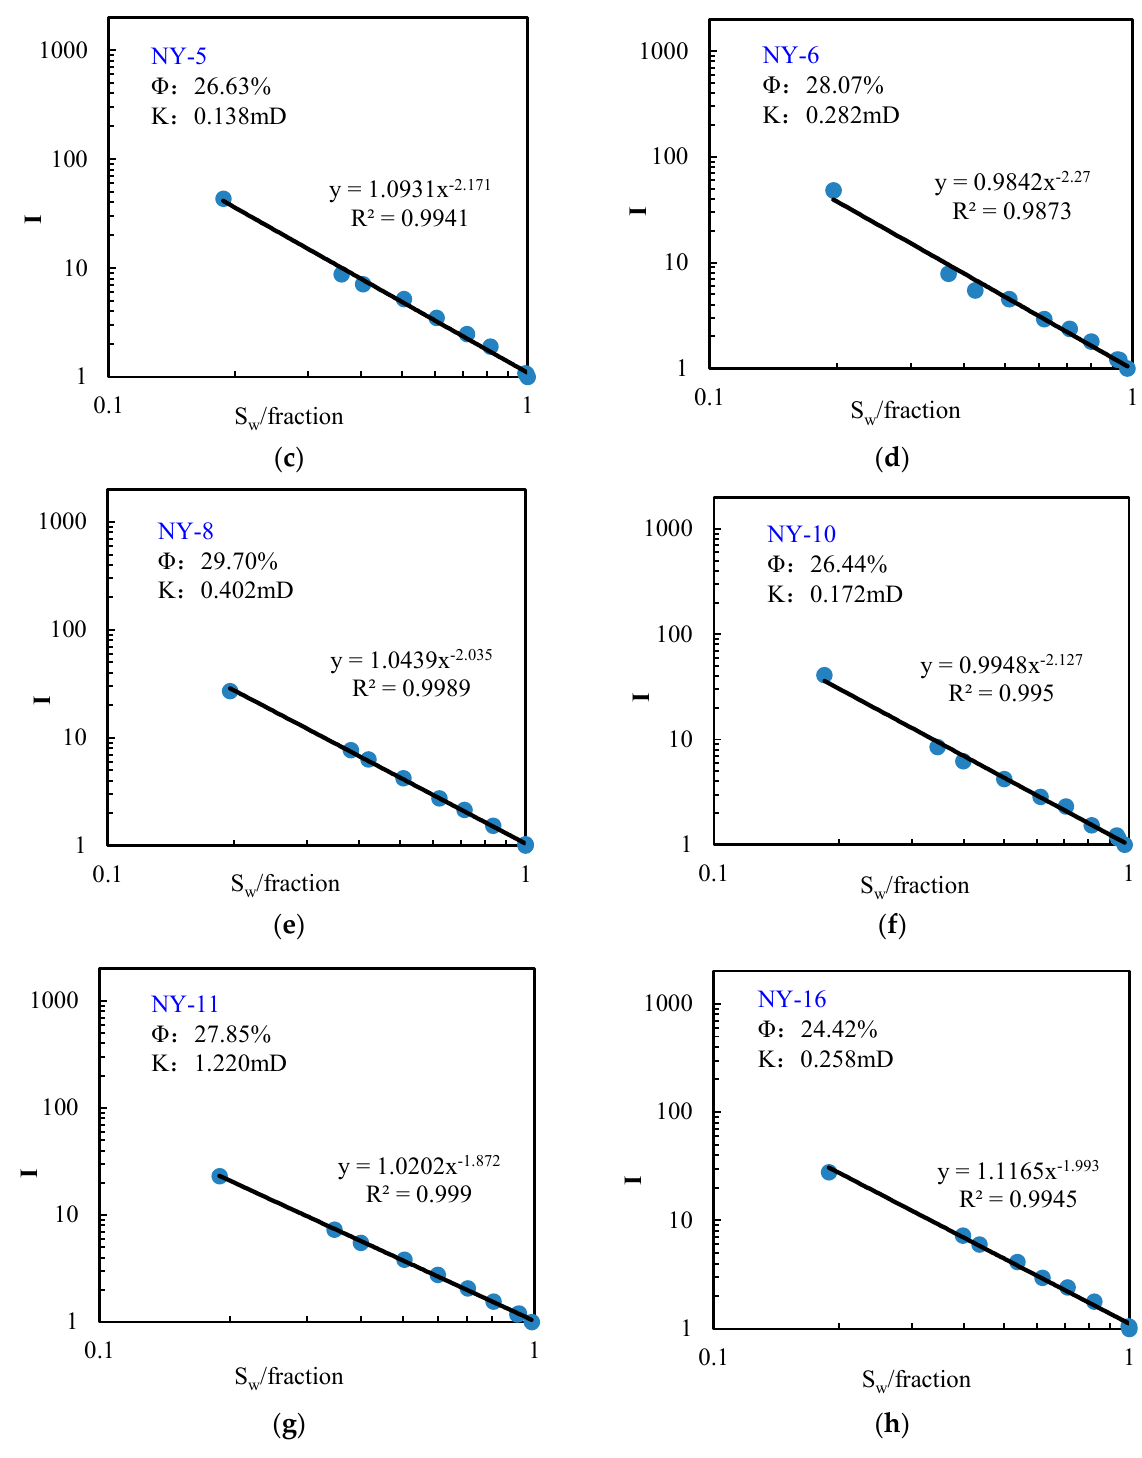
Figure 4. Relationship between resistivity index and water saturation of core samples. ( a ) No. NY - 2. ( b ) No. NY - 3 . ( c ) No. NY - 5 . ( d ) No. NY - 6 . ( e ) No. NY - 8 . ( f ) No. NY - 10 . ( g ) No. NY - 11 . ( h ) No. NY - 16 .